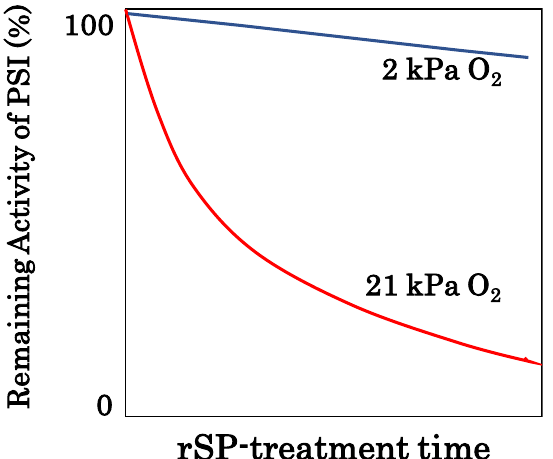
Figure 3. Repetitive short-pulse (rSP) illumination treatment inactivates PSI. In angiosperms, rSP illumination treatment of the intact leaves inactivates PSI activity [38]. The inactivation is suppressed under low O 2 conditions (2 kPa O 2 ). Short-pulse illumination reduces O 2 to a superoxide radical, O 2 − , and the accumulated O 2 − from rSP illumination treatment oxidatively attacks PSI components. Red line: the PSI activity gradually decreases as rSP illumination treatment proceeds under atmospheric O 2 (21 kPa) condition; blue line: PSI inactivation by rSP illumination treatment is suppressed under low O 2 (2 kPa)